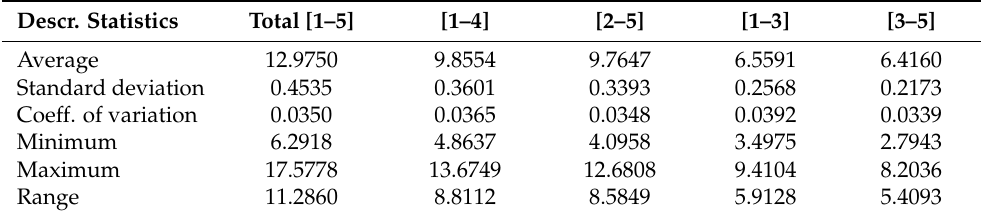
Table 11. The descriptive statistics of the mean MSAVI cumulative values across all cumulative ranges and pilot fields.